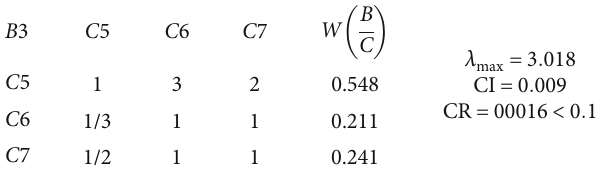
Table 5: Judgment matrix B 3 ~ Ci ð i = 5 ~ 7 Þ .